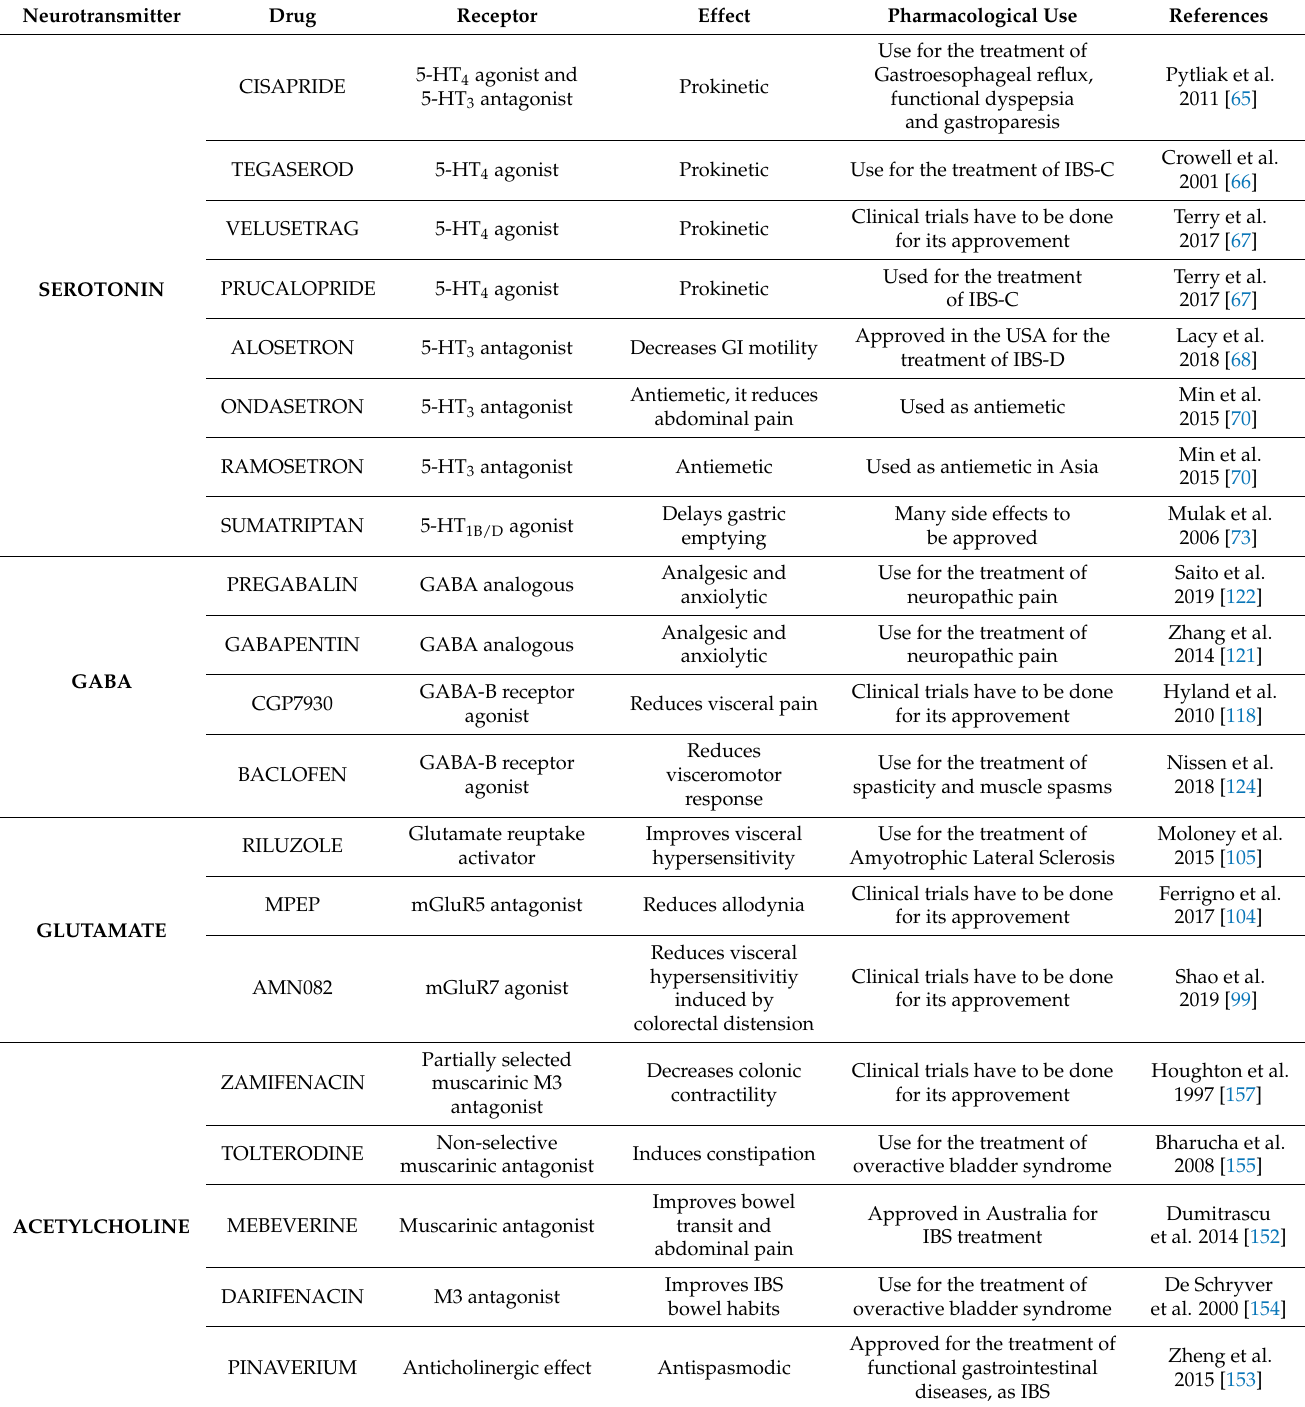
Table 1. Summary of the drugs targeting neurotransmitters used in